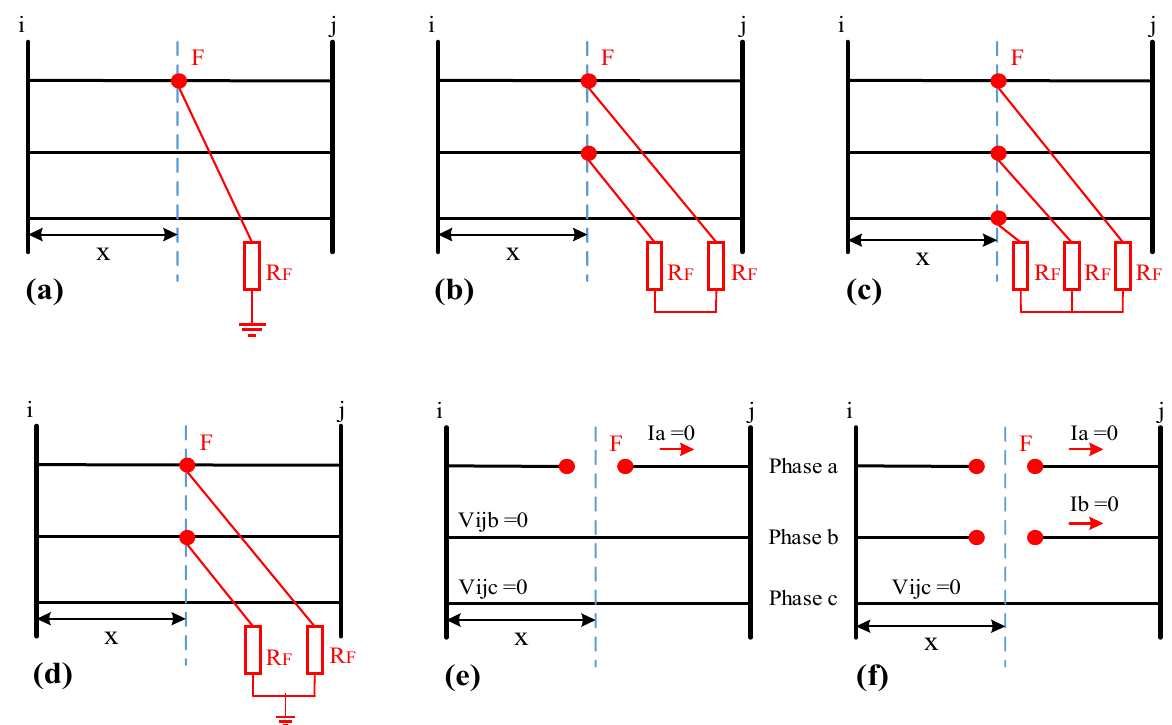
Figure 11. Types of short-circuit and series faults, ( a ) single-phase fault to ground, ( b ) two-phase fault, ( c ) three-phase fault, ( d ) two-phase fault to ground, ( e ) One open conductor, ( f ) Two open conductors.